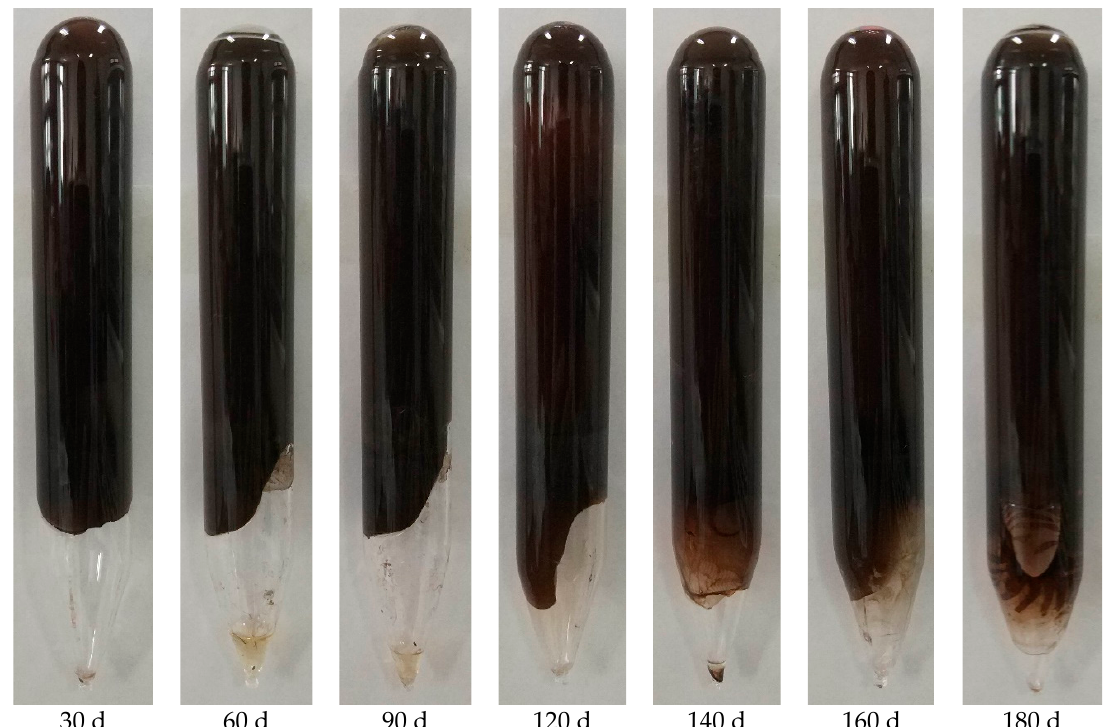
Figure 6. Pictures of gel samples at different heat treatment time.